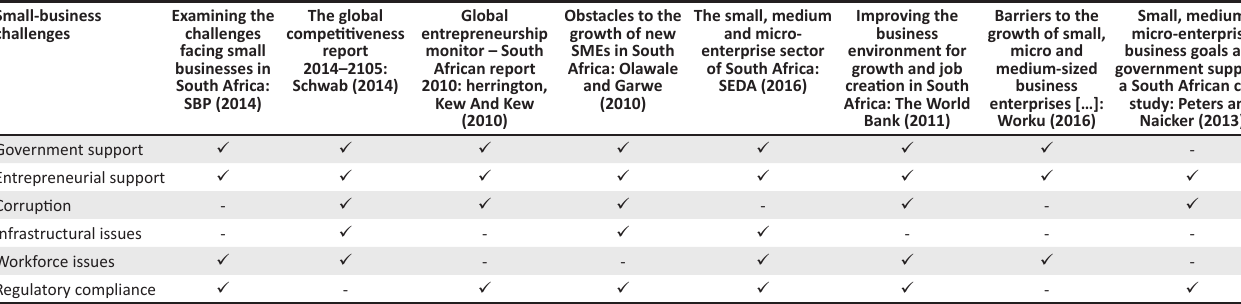
TABLE 1: Issues facing South African small